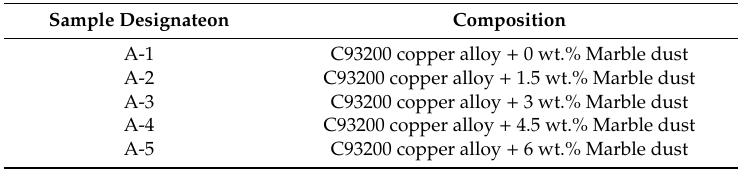
Figure 1. Scanning electron microscope (SEM) micrograph of marble dust powder. Table 1. Detailed composition of composites.